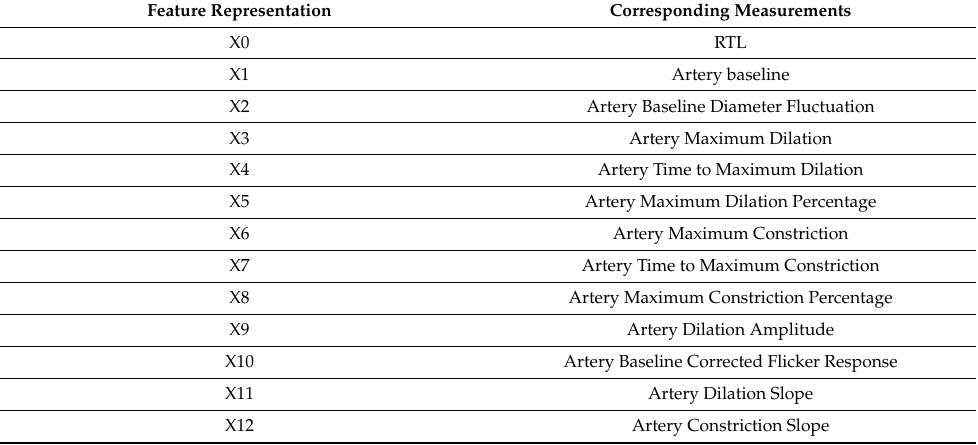
Table 3. Artery measurements and telomere encodings for the symbolic regression